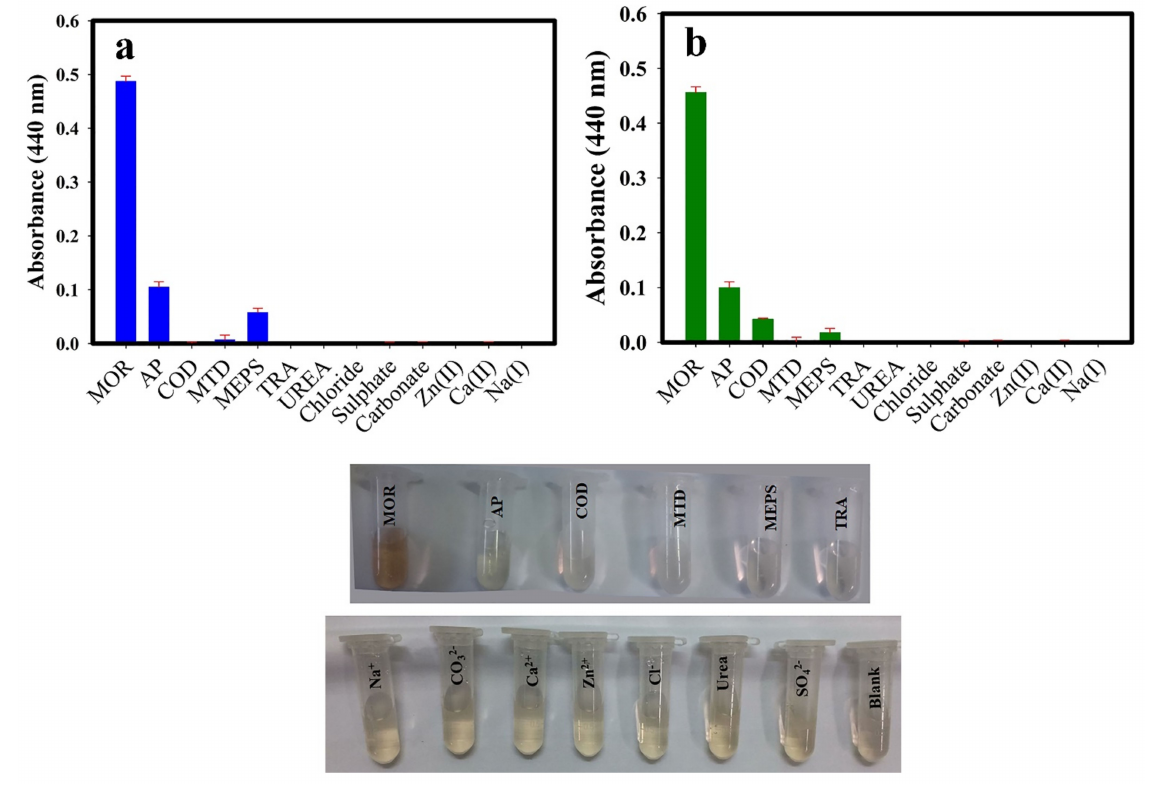
Figure 9. ( a ) UV-visible spectra of ( a ) Au@Ag (P) and ( b ) Au@Ag (B) NPs solutions with different drugs, urea, cations, and anions where the concentration of drugs and all other interferences was 100 µ g/mL, and related photographic images. Table 4. Analysis of MOR in spiked urine samples by the proposed method (incubation time: 5 min).